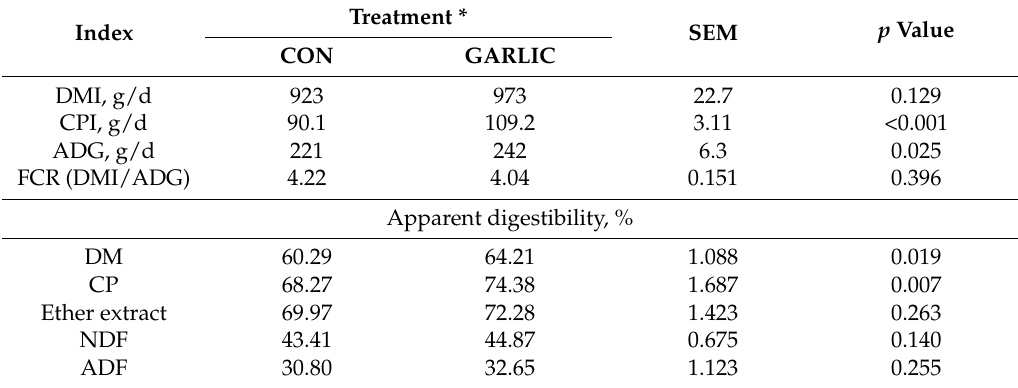
Table 2. Effects of garlic powder supplementation on body weight gain, dry matter intake, and feed digestion of lambs infected with gastrointestinal